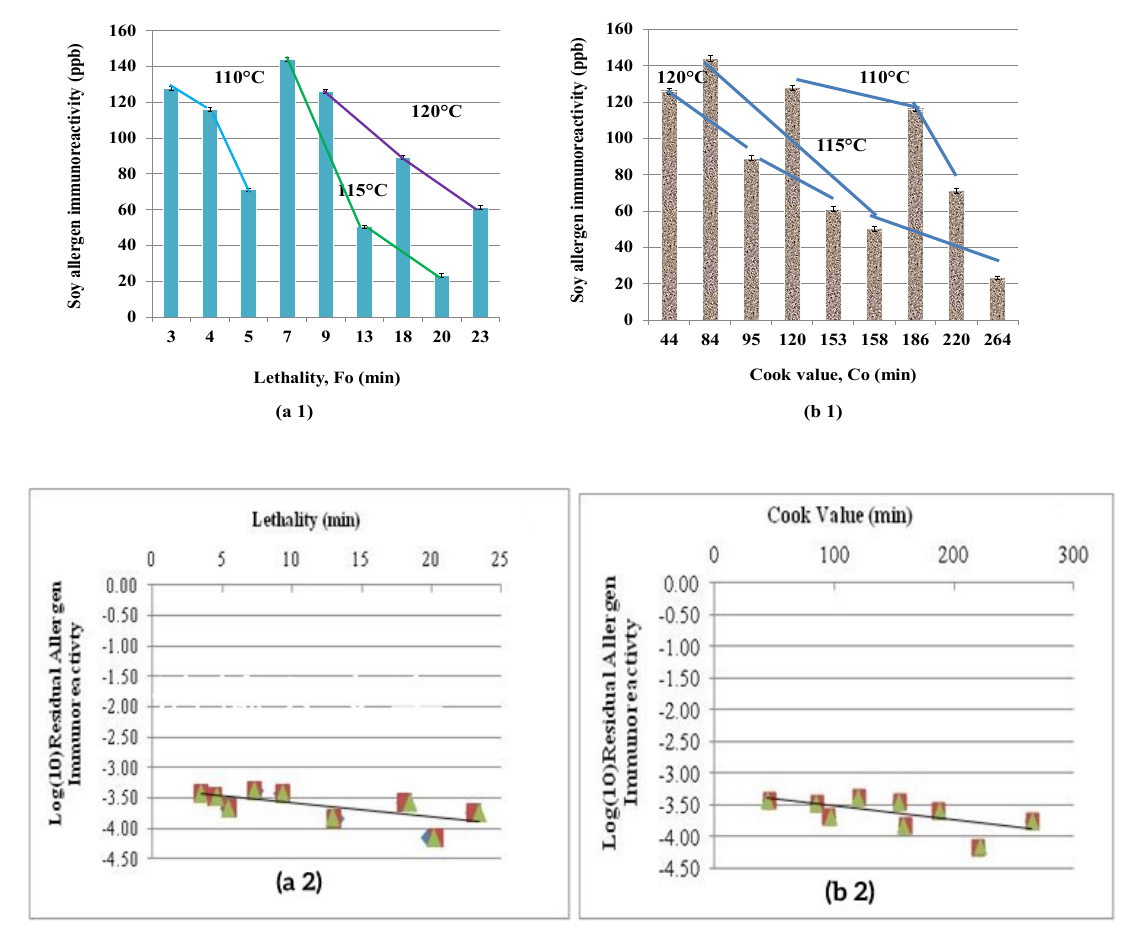
Figure 3. Effect of lethality ( a1 , a2 ) and cook value ( b1 , b2 ) on reduction of soy IR in linear and semi-logarithmic